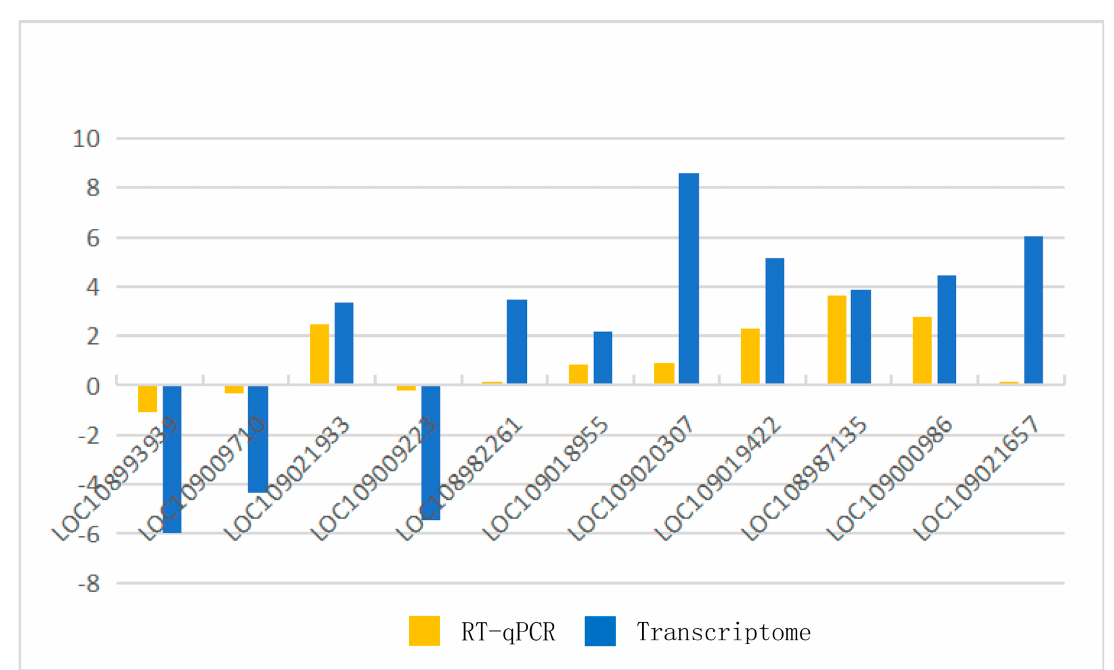
Figure 3. Differences in gene expression were verified by RT-qPCR.